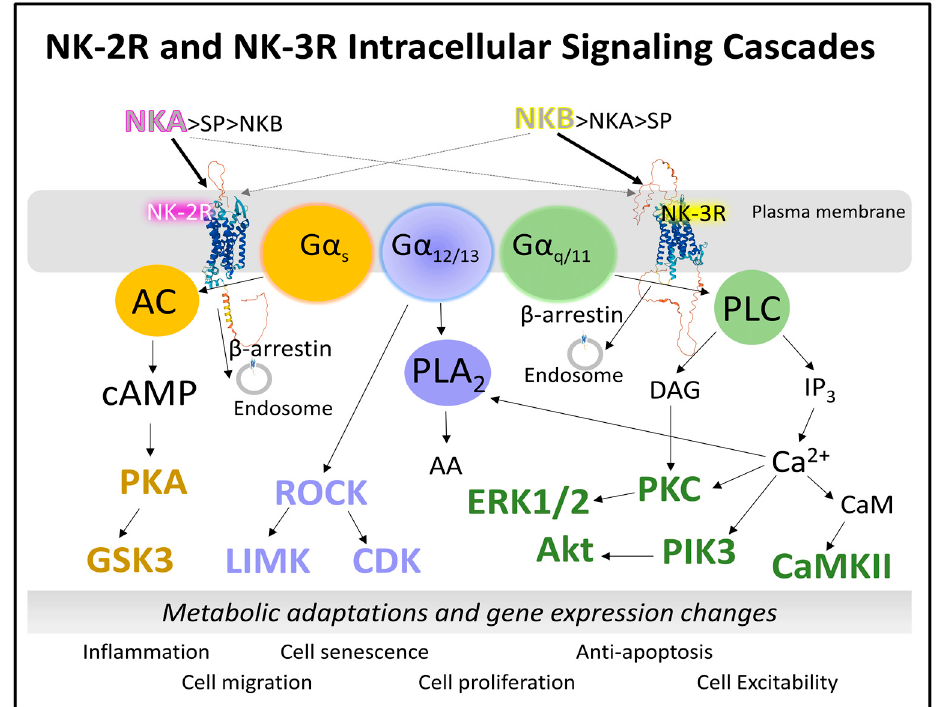
Figure 6. Schematic representation of signaling cascades triggered by NK-2R and NK-3R. Both receptors may recruit G α subunits to activate phospholipase C, adenylyl cyclase, or phospholipase A2. Consequently, phosphorylation reactions lead to rapid metabolic changes, the appearance of inflammatory messengers, cell proliferation, cell migration, and the arrangement of cytoskeletal proteins or cell excitability (see text for details). Abbreviations: AA, arachidonic acid; AC, adenylyl cyclase; Akt, Ak strain transforming protein kinase; cAMP, cyclic 3 ′ -5 ′ adenosine monophosphate; CDK, cyclin-dependent kinase; ERK, extracellular signal-regulated receptor kinase; DAG, diacylglycerol; GSK3 (glycogen synthase kinase); IP3, inositol 1,4,5-trisphosphate; LIMK, LIM protein domains (LIN-11, Isl-1, and MEC-3) kinase; NKA, neurokinin A; NKB, neurokinin B; PLA2, phospholipase A2; PKA, protein kinase A; PKC, protein kinase C; PLC, phospholipase C; ROCK, Rho (Ras-homologous)-associated coiled-coil kinase.